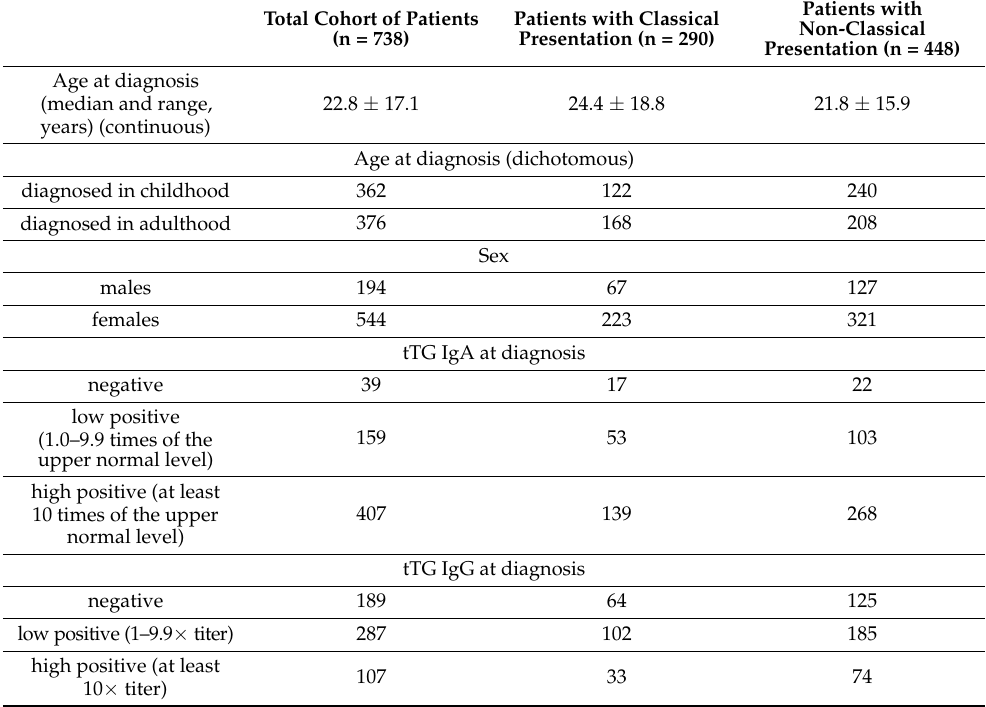
Table 1. Characteristics of patients